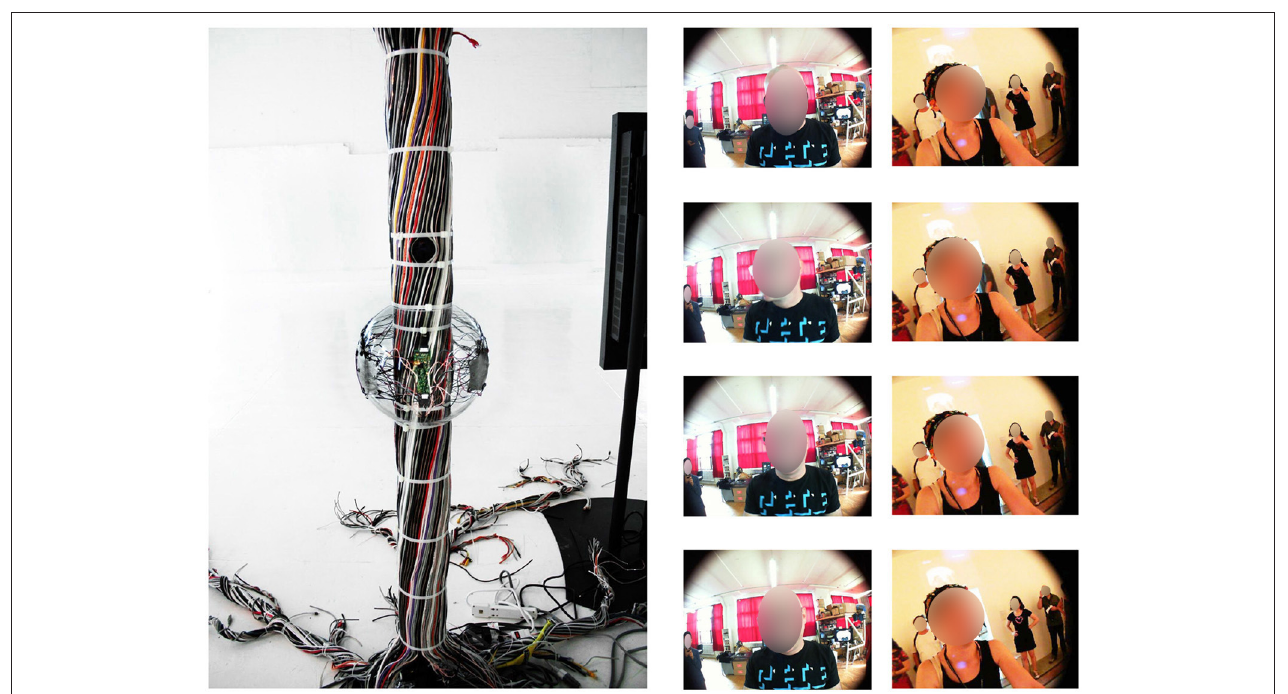
FIGURE 3 | Emergence installation at open house gallery, New York City (left) and digital memories triggered by successive heartbeats and uploaded to Flickr (right). Left image by Sean Montgomery. Right images by Emergence courtesy of Sean Montgomery. Web: http://produceconsumerobot.com/emergence/; Leonardo Electronic Almanac Vol 18 No 5 p